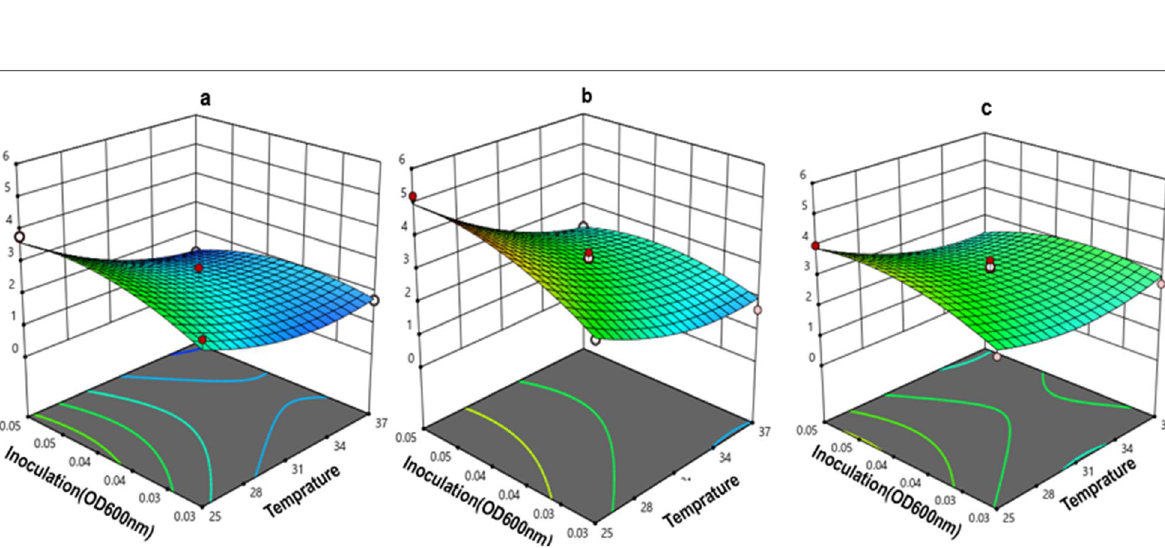
Fig. 1 Normal probability and the relationship between the predicted and actual values graphs. ( a ) The plot showed that the data were normally distributed. ( b ) The plots showed the relationship between the predicted and actual values of SAK expression as a response at Hsp27 SILEX system. The closeness of scattered data to the diagonal line confirmed that model fitted the empirical data adequately